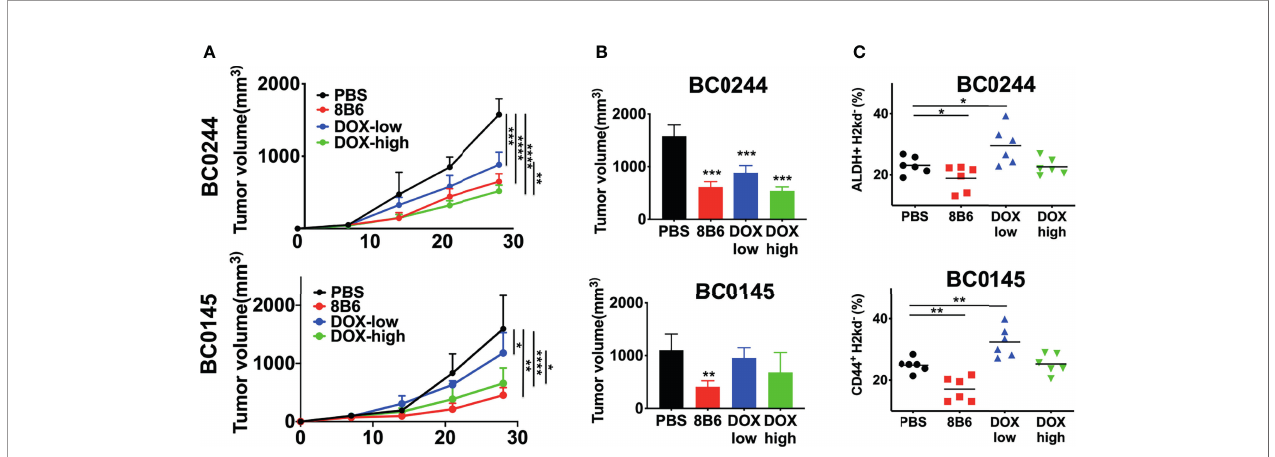
FIGURE 2 | Treatment with mAb8B6 suppresses breast cancer growth and reduces cancer stem cells. (A) Growth inhibition of BC0244 and BC0145 PDX tumors in NOD/SCID mice. Mice (n = 6/group) were inoculated with PDX cells (5 × 10 5 cells) at the mammary fat pad. When the tumor volume reached 100 mm 3 , these mice were intravenously injected with either PBS, 2 mg/kg doxorubicin (DOX-high), 0.5 mg/kg doxorubicin (DOX-low), or mAb8B6 (5 mg/kg) weekly for four times. Tumor volumes were measured every 3 days, and tumor growth was depicted as mean tumor volume for each group. The slope of tumor growth was determined by linear regression. (B) Tumor volume was measured before sacri fi ce (3 days after the last treatment). (C) BCSCs frequency in BC0244- and BC0145-derived tumors was identi fi ed with ALDEFLUOR ™ kit and CD44-APC/CD24-FITC, respectively. Data representative of three experiments and values are expressed as mean±SD and analyzed by one-way ANOVA. * p < 0.05, ** p < 0.01, *** p < 0.001, **** p < 0.0001.